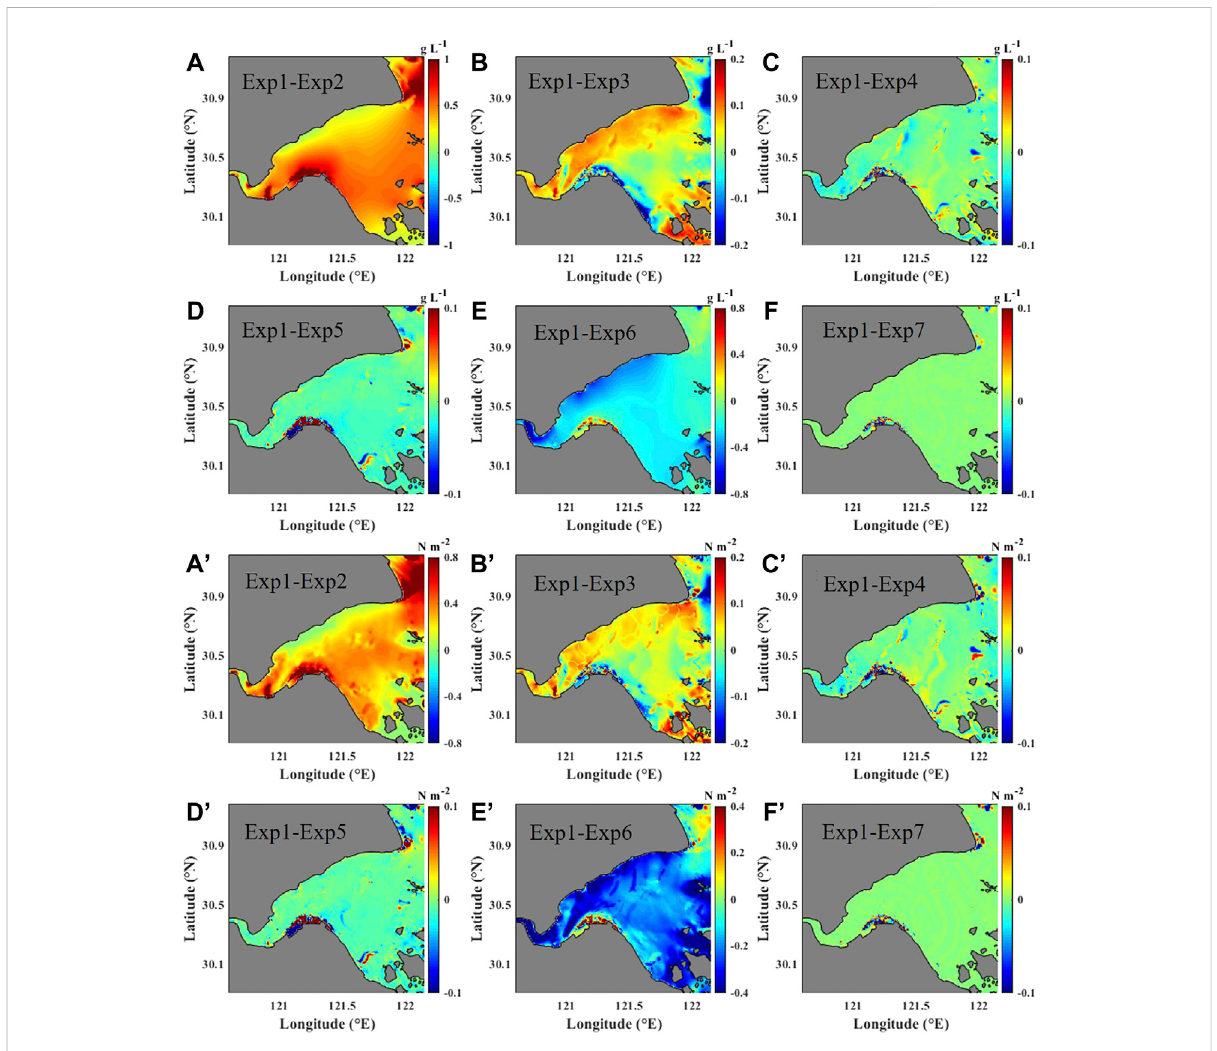
FIGURE 12 Differences of 50 h averaged (A – F) near-bottom SSC and (A ’– F ’ ) bottom stress during the Typhoon